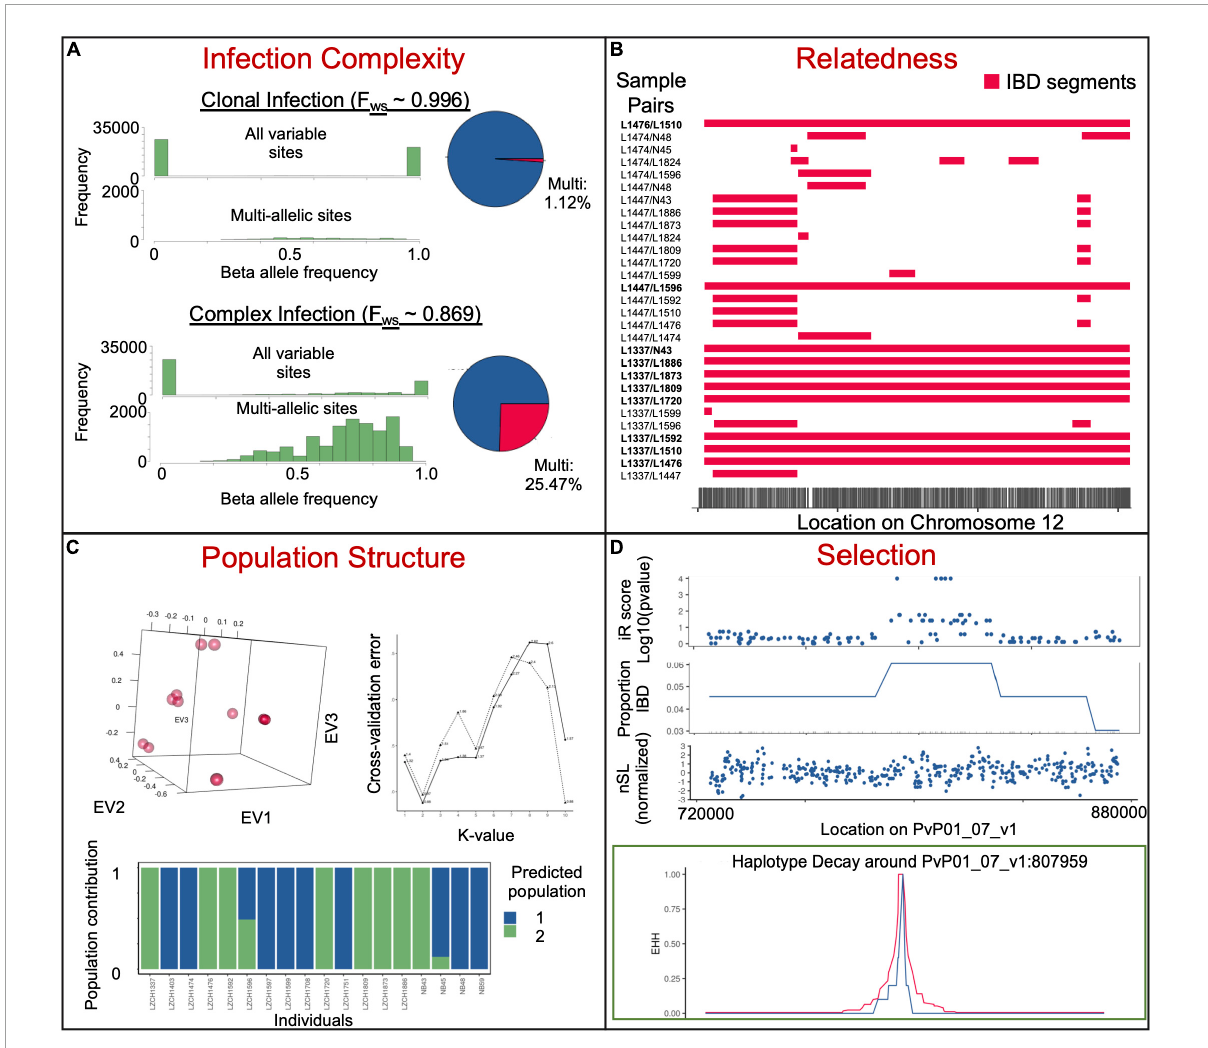
FIGURE3 Example insights into parasite populations from whole-genome sequencing data. (A) Different beta allele frequencies for samples previously determined to be clonal (upper) and complex (lower) via F ws analysis. The top histogram shows all sites, while the bottom shows only sites with reads mapping to more than one allele. Pie charts on the right represent the number of sites with more than 5% of mapped reads mapping to each of the two alleles. (B) Identical-by-descent segments on chromosome 12 within selected sample pairs. (C) Population structure of 18 clonal samples from the China–Myanmar border. PCA (top left), admixture K -value cross-validation identifying ideal population numbers based on SNPs (top right) and admixture analysis at the ideal K -value (bottom). (D) Genome scans for selection (iR score, proportion pairs IBD and nSL) on a fragment of chromosome 7 and haplotype decay 100 kb around an SNP at the center of a region based on 11 genetically distinct China-Myanmar border samples. Data is subset from a larger dataset (Brashear et al.,